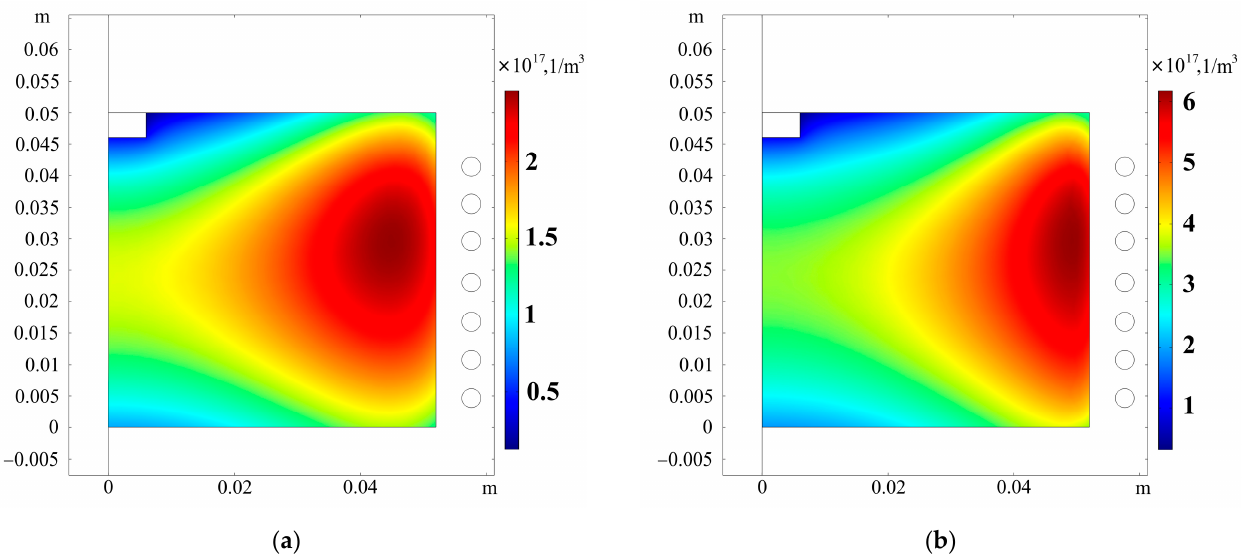
Figure 5. Two-dimensional distribution of charged particle density over the DC volume in the case of using a side antenna: ( a ) xenon flow rate of 0.5 mg/s, RF power of 122 W, extracted ion current of 140 mA; ( b ) xenon flow rate of 1 mg/s, RF power of 204 W, extracted ion current of 300 mA.